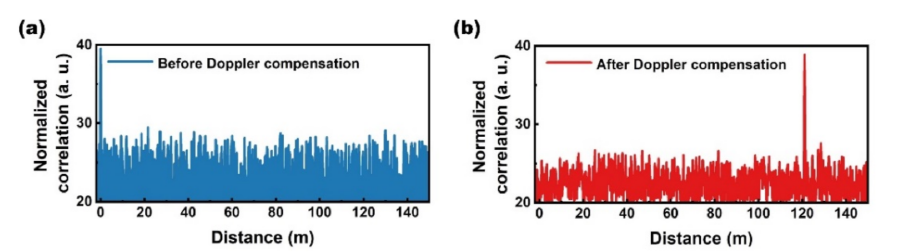
Figure 8. Normalized correlation ( a ) before Doppler compensation and ( b ) after Doppler compensa- tion. A 77-MHz optical DFS is simulated by an AOM and the length of a fiber spool is measured.